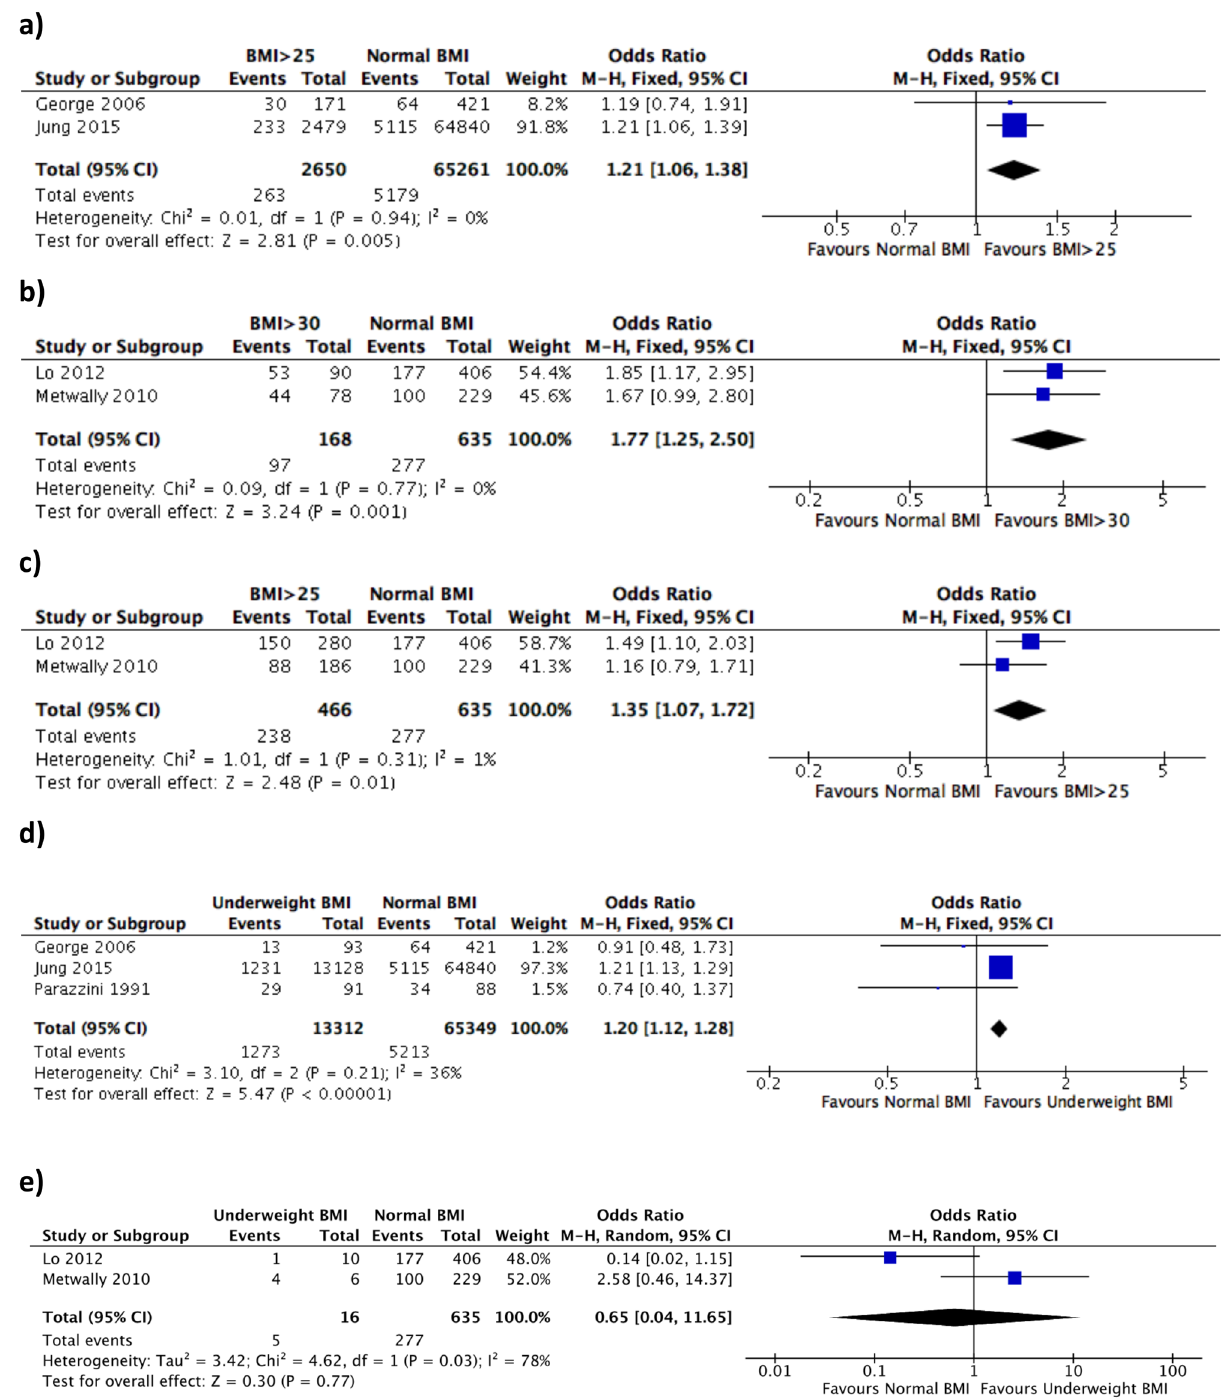
Figure 2. Forest plot demonstrating meta-analysis of the effect of BMI on RPL and further miscarriage. ( a ) BMI > 25 significantly increases risk of RPL in general population. ( b ) BMI > 30 significantly increases risk of further miscarriage in RPL population. ( c ) BMI > 25 significantly increases risk of further miscarriage in RPL population. ( d ) Underweight BMI significantly increases risk of RPL in general population. ( e ) Underweight BMI has no effect on risk of further miscarriage in RPL population. 95% CI = 95% confidence interval; M-H = Mantel–Haenszel statistical